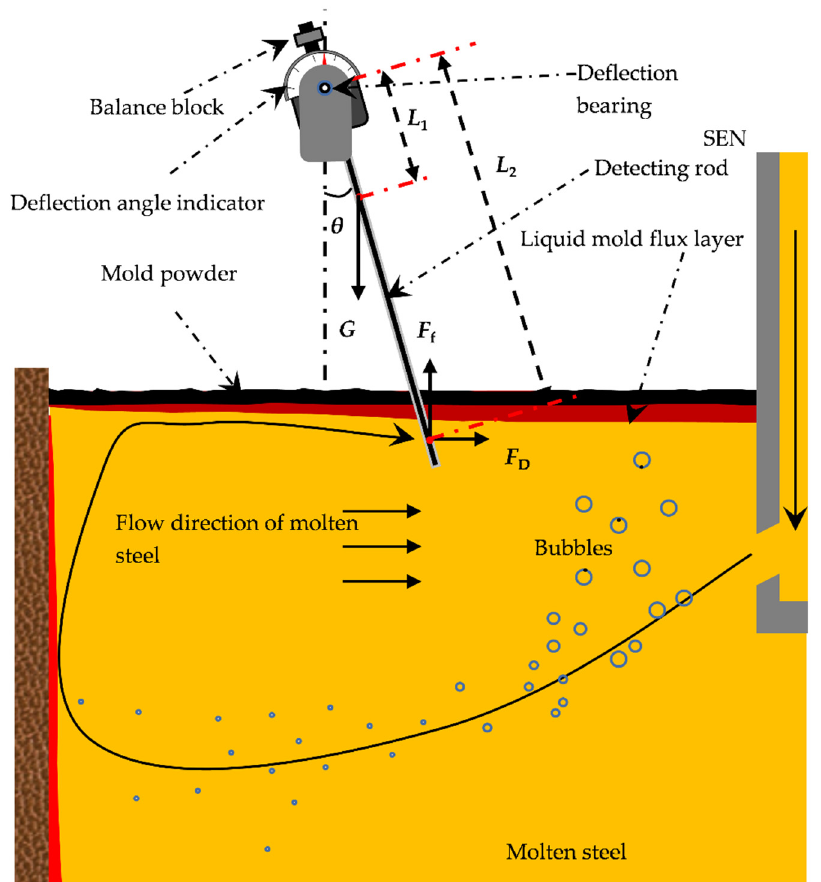
Figure 1. Schematic diagram of measuring velocity near the mold surface by the rod deflection method.